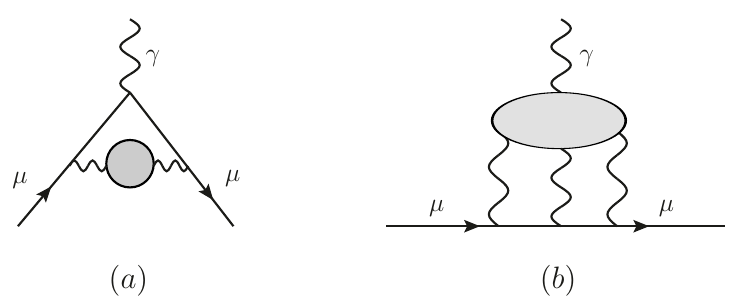
Figure 1. Diagrammatic representation of ( a ) HVP and ( b )